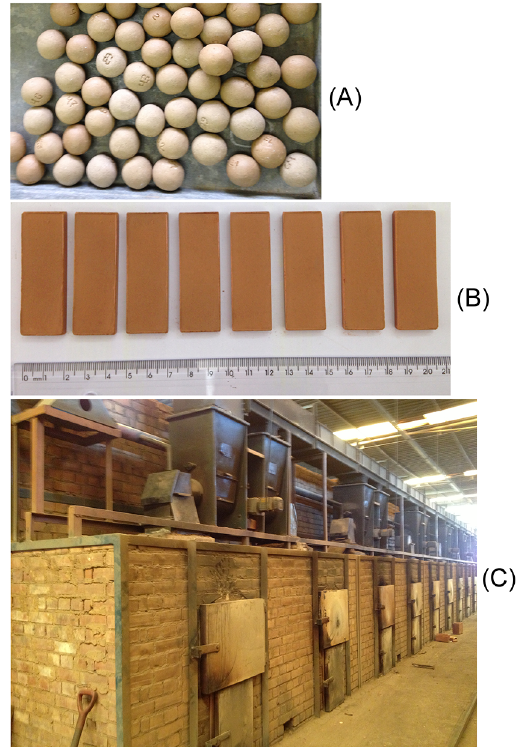
Figure 1. Details of specimens and the industrial furnace-type tunnel Table 1. Chemical composition by